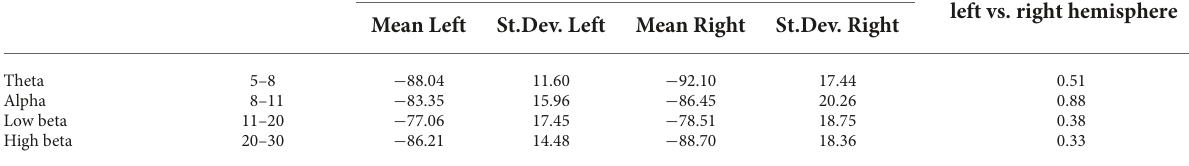
left vs. right hemisphere